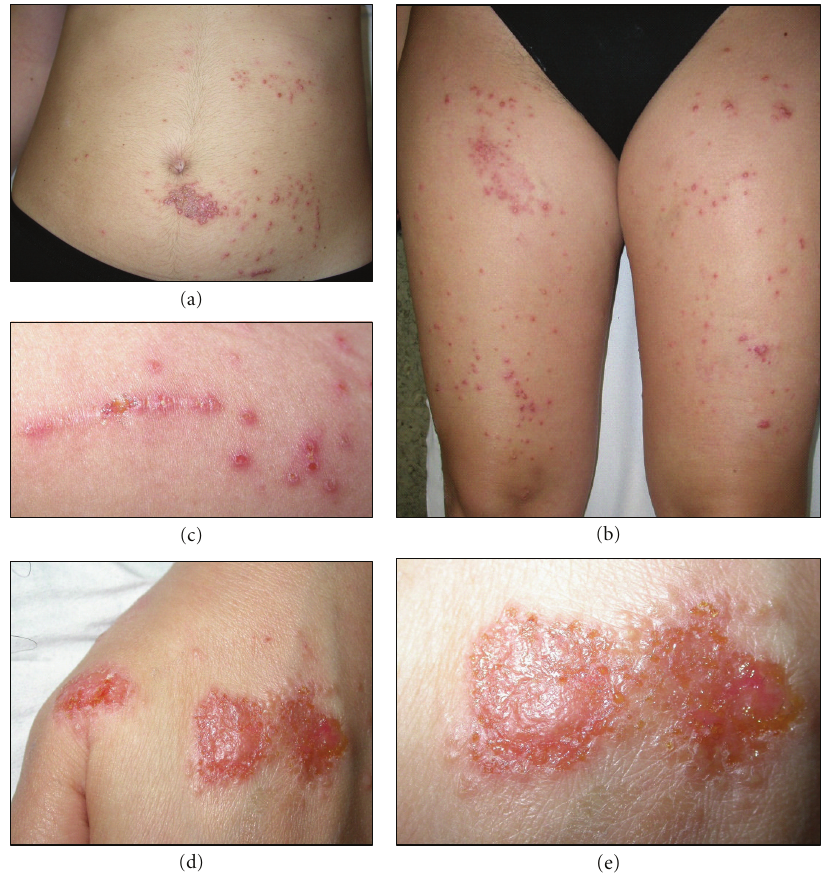
Figure 1: Erythematous, popular, and vesiculosus lesions in a patient with